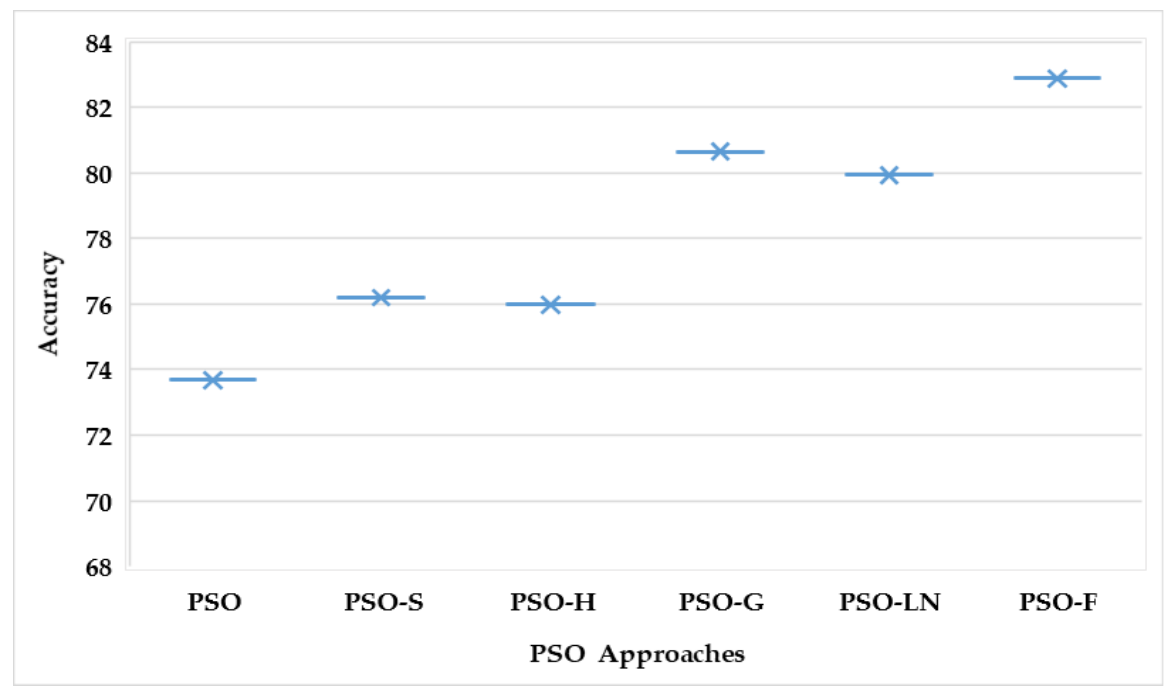
Figure 10. Result of one-way ANOVA test on testing accuracy (QRS with PSO approaches). FFNN Classification Accuracy of QRS with Opposition-Based PSO